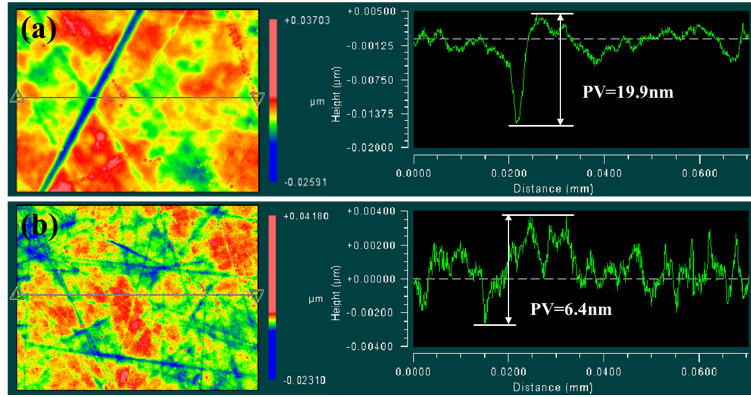
Figure 6. Morphologies and profile curves of the sapphire substrate polished by diamond ( a ) and hybrid ( b ) abrasives.